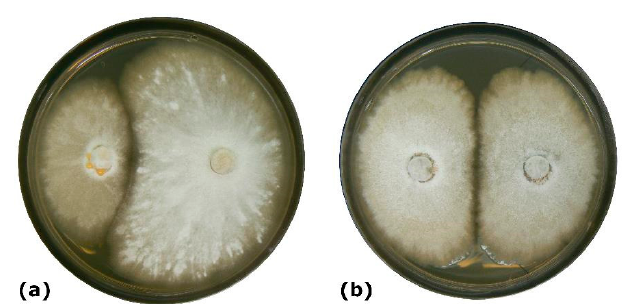
Figure 3. Mycelial interactions after 18 days of co-incubation between: ( a ) Response (left) and challenge (right) isolate of E. parasitica and ( b ) two response isolates of E. parasitica (self-inhibition). The results of the Kruskal–Wallis statistical test revealed significant differences ( p < 0.001) in the average antagonistic ability of challenge isolates between different dual culture assays. Pairwise comparisons revealed statistically significant differences ( p < 0.05) for the average AI score between E. parasitica ZLVG 791 (a dual culture assay) on one hand and Eutypa sp., Eu. maura , Neonectria sp. and P. incarnata on the other. The same results were obtained with E. parasitica ZLVG 805 (a self- inhibition test) (Table 3).